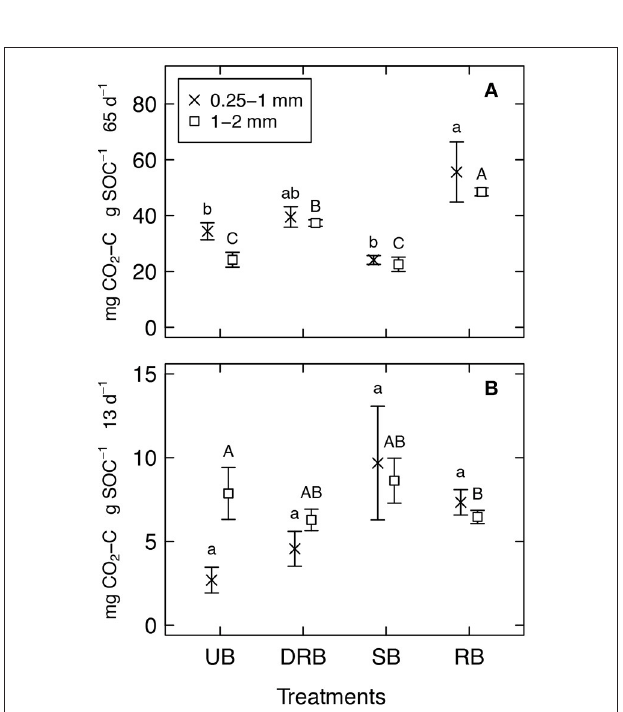
FIGURE 6 | Cumulative SOC loss from unburned (UB), rapidly burned dried (DRB), rapidly burned (RB), and slowly burned (SB) soil aggregates from forest soil (A) and shrubland soil (B) . Different letters represent significantly different means, as determined from Tukey’s HSD Test ( P < 0.05), among aggregates in the 0.25–1mm (lower case letters) and 1–2mm (upper case letters) size